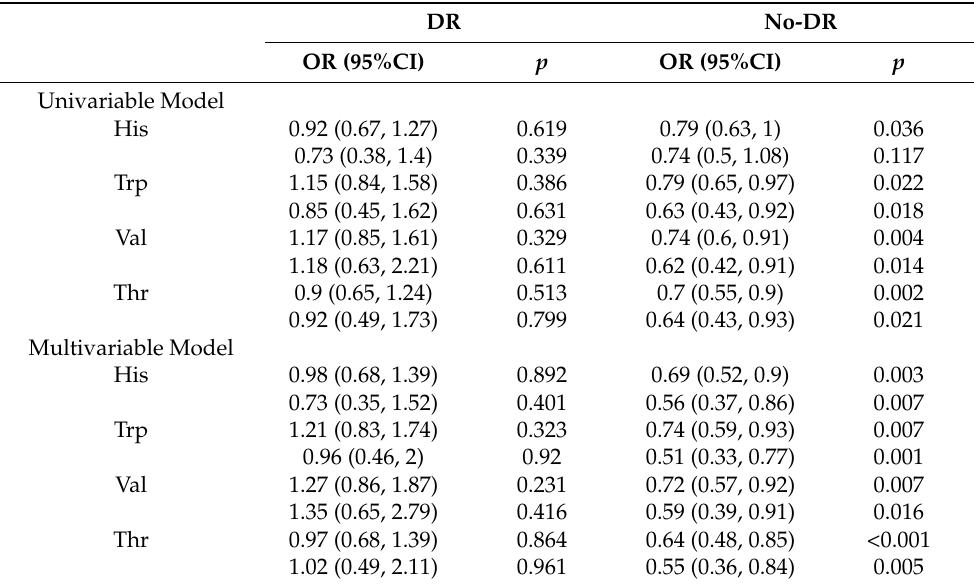
Table 3. Odds ratio of significant amino acid for the risk of diabetic nephropathy stratified by diabetic retinopathy.